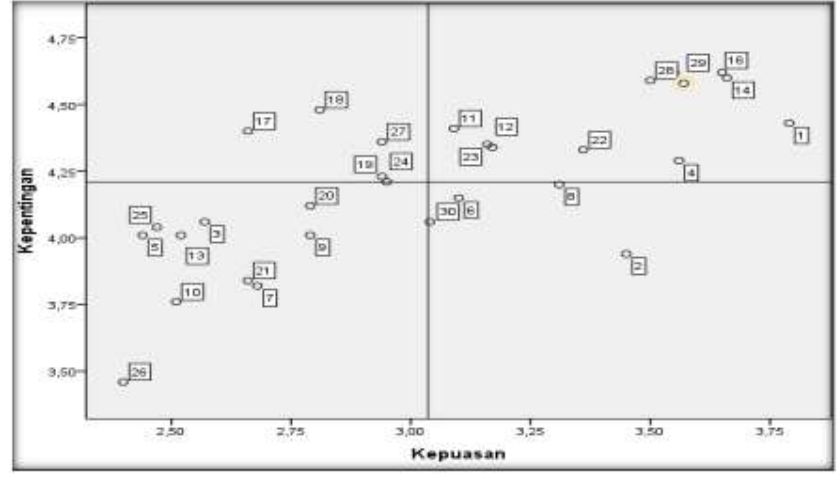
Figure 1. Analysis of Importance Performance Analysis Quadrant Model Source: Adapted,